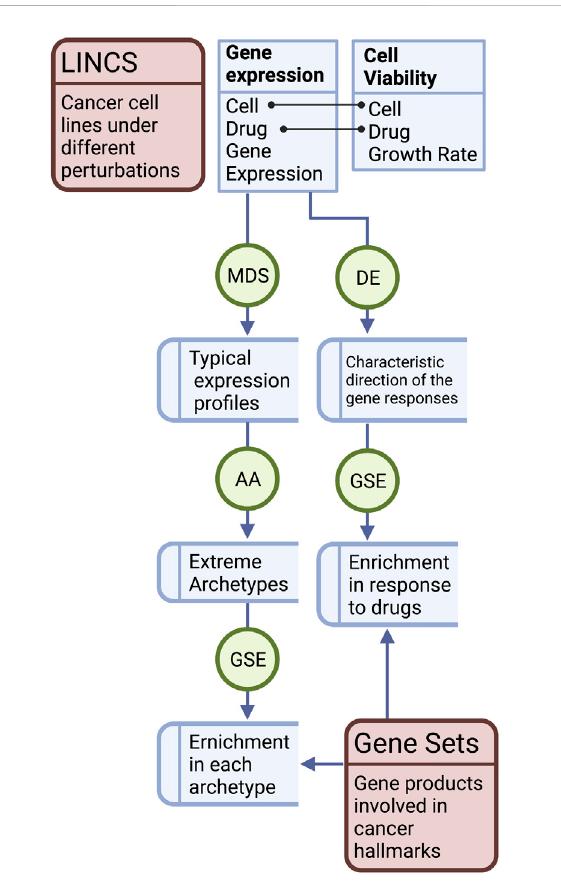
FIGURE 1 Work fl ow of the study. Gene expression data of the cancer cell lines were used to determine the typical expression pro fi les and the response to treatments in the form of differential expression (DE) characteristic direction (CD) of change. Typical gene expression pro fi les of the cancer cell lines were subjected to multidimensional scaling (MDS), archetype analysis (AA), and correlation analysis with the CD of the drug treatments. The correlations in MCF7 were plotted against growth inhibition rates of the cell line treated with the same set of drugs. Gene set enrichment analysis (GSEA) of the cancer hallmarks was performed in the pure archetypes of the cell lines and their responses to drugs was analyzed. The correlation between the enrichment scores of the archetypes and the drug response was